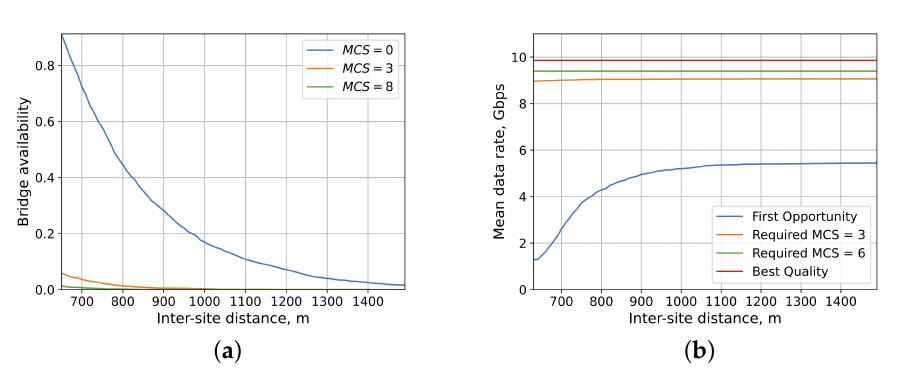
Figure 8. Bridge availability and data rate. ( a ) different MCSs; ( b ) different last hop selection